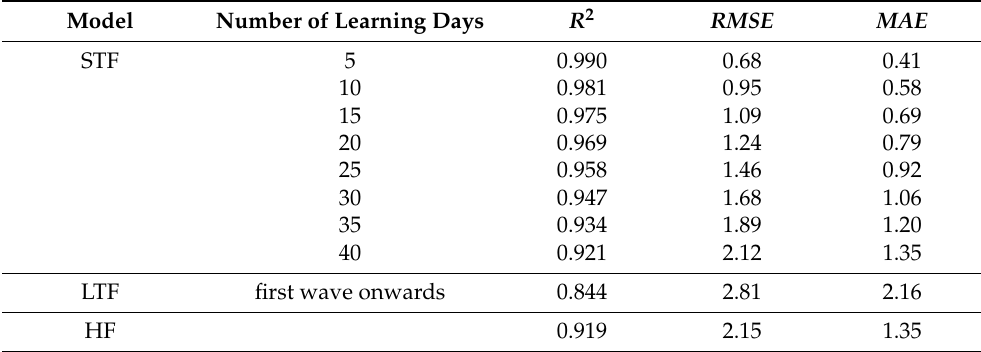
Table 1. A table showing the evaluation metrics of short-term forecast (STF), long-term forecast (LTF) and hybrid forecast (HF)